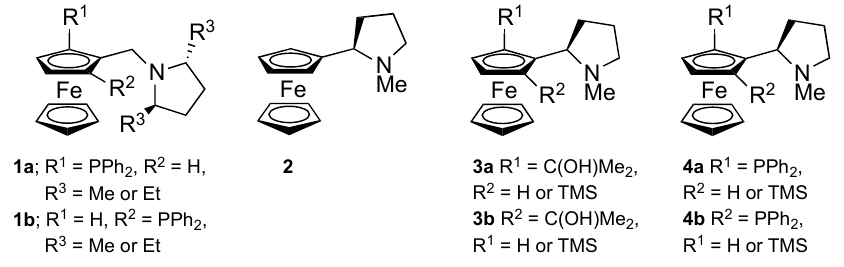
Figure 2. Selected ferrocene-pyrrolidine containing ligands.